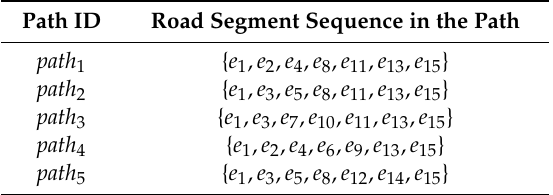
Figure 5. Clustering for low-sampling-rate GPS trajectories. Table 1. Paths and the corresponding road segment sequences.